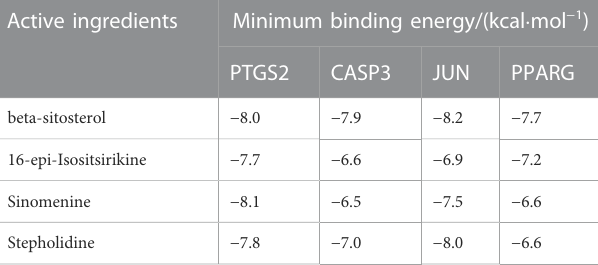
TABLE 3 Minimum binding energy between the active ingredients and the main targets of SA. Active